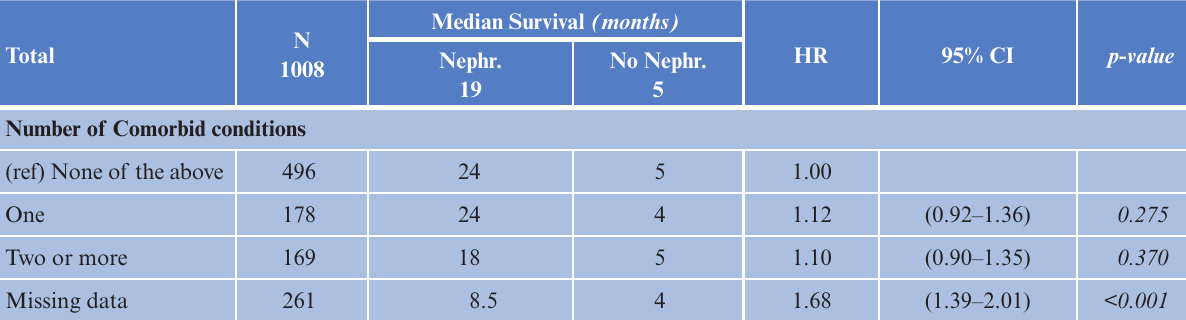
Table 5 (Continued): Metropolitan Detroit Distant Stage Kidney Cancer: 2000–2013 Survival Analysis by Nephrectomy Status for Demographic Characteristics and Comorbidities.